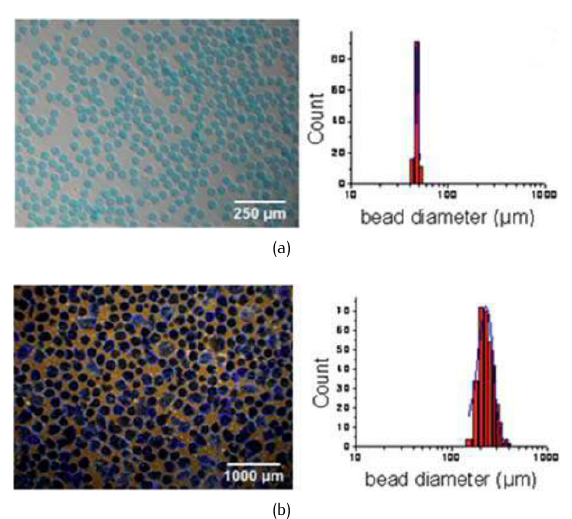
Figure 3. MicroscopyimagesofusingDOD(A)andCIJ(B)printedre- versible calcium alginate porogens. These were fabricated by jetting sodium alginate into a bath of calcium chloride solution [44].